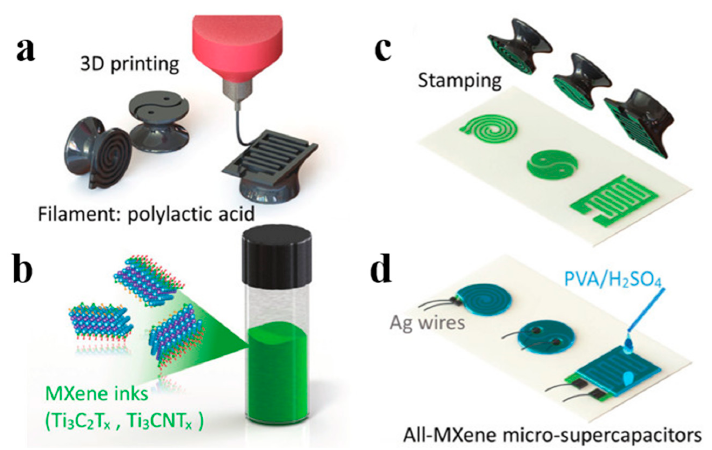
Figure 12. Fabricating the all-MXene micro supercapacitors with imprinting technique. ( a ) 3D printing process to create different shapes of seals; ( b ) Mxene inks; ( c ) Imprinting process; ( d ) All-